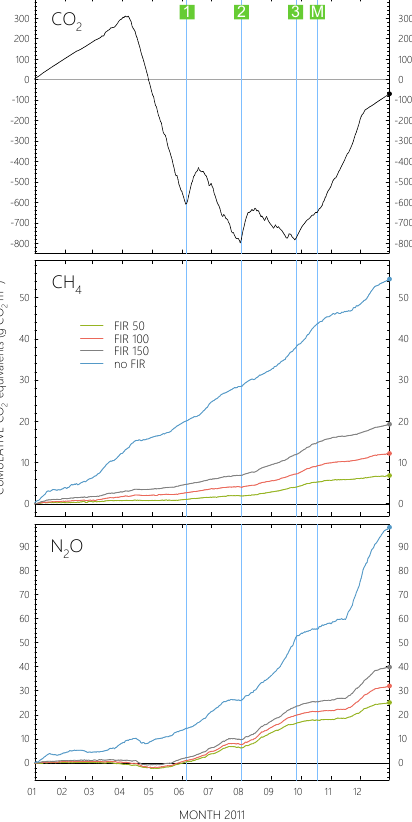
Figure 6. Cumulative GHG fluxes in 2011 expressed as CO 2 equiv- alents. The effect of the finite impulse response (FIR) filter with different time constants is shown for CH 4 and N 2 O budgets. Verti- cal lines show management dates, the numbers 1, 2 and 3 in green squares indicate the first, second and third cutting of the meadow, respectively, while M denotes manure